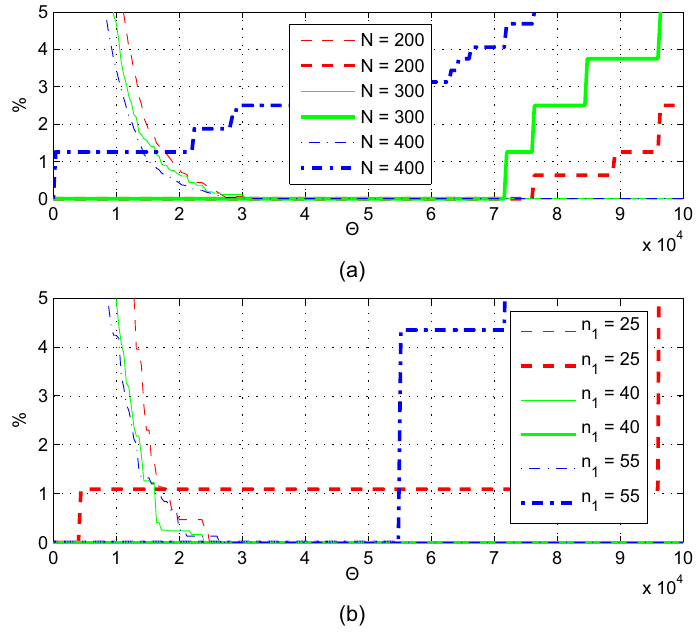
and ( b ) N values. 1